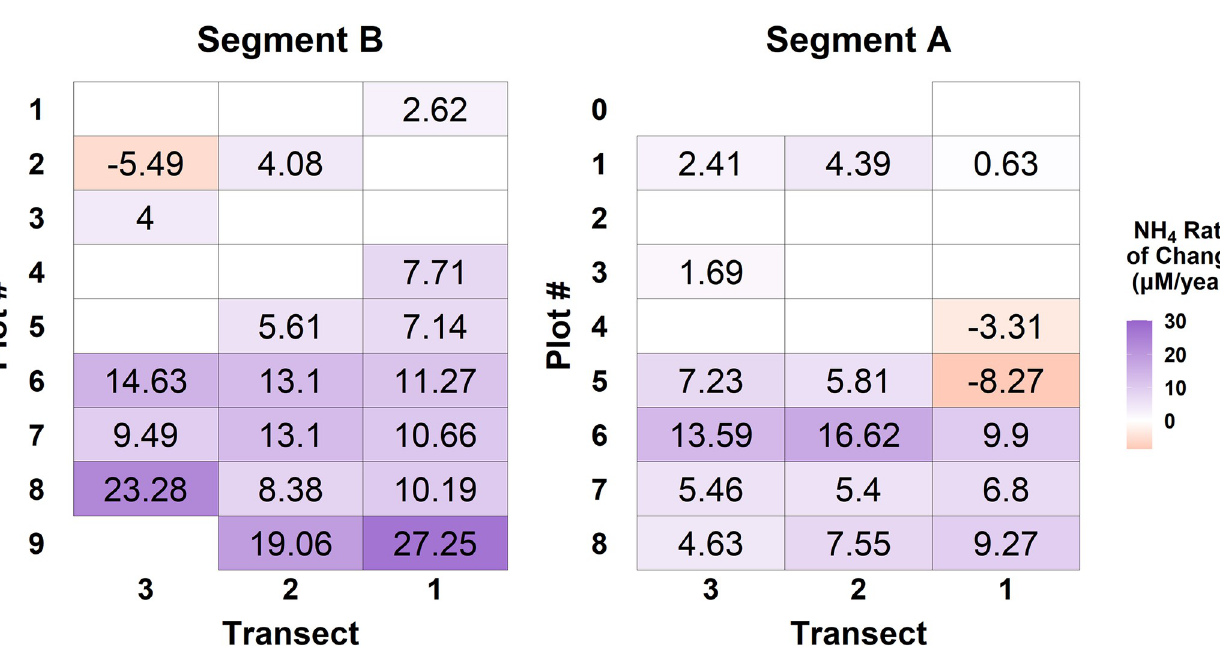
PLOS ONE | https://doi.org/10.1371/journal.pone.0278215 November28,